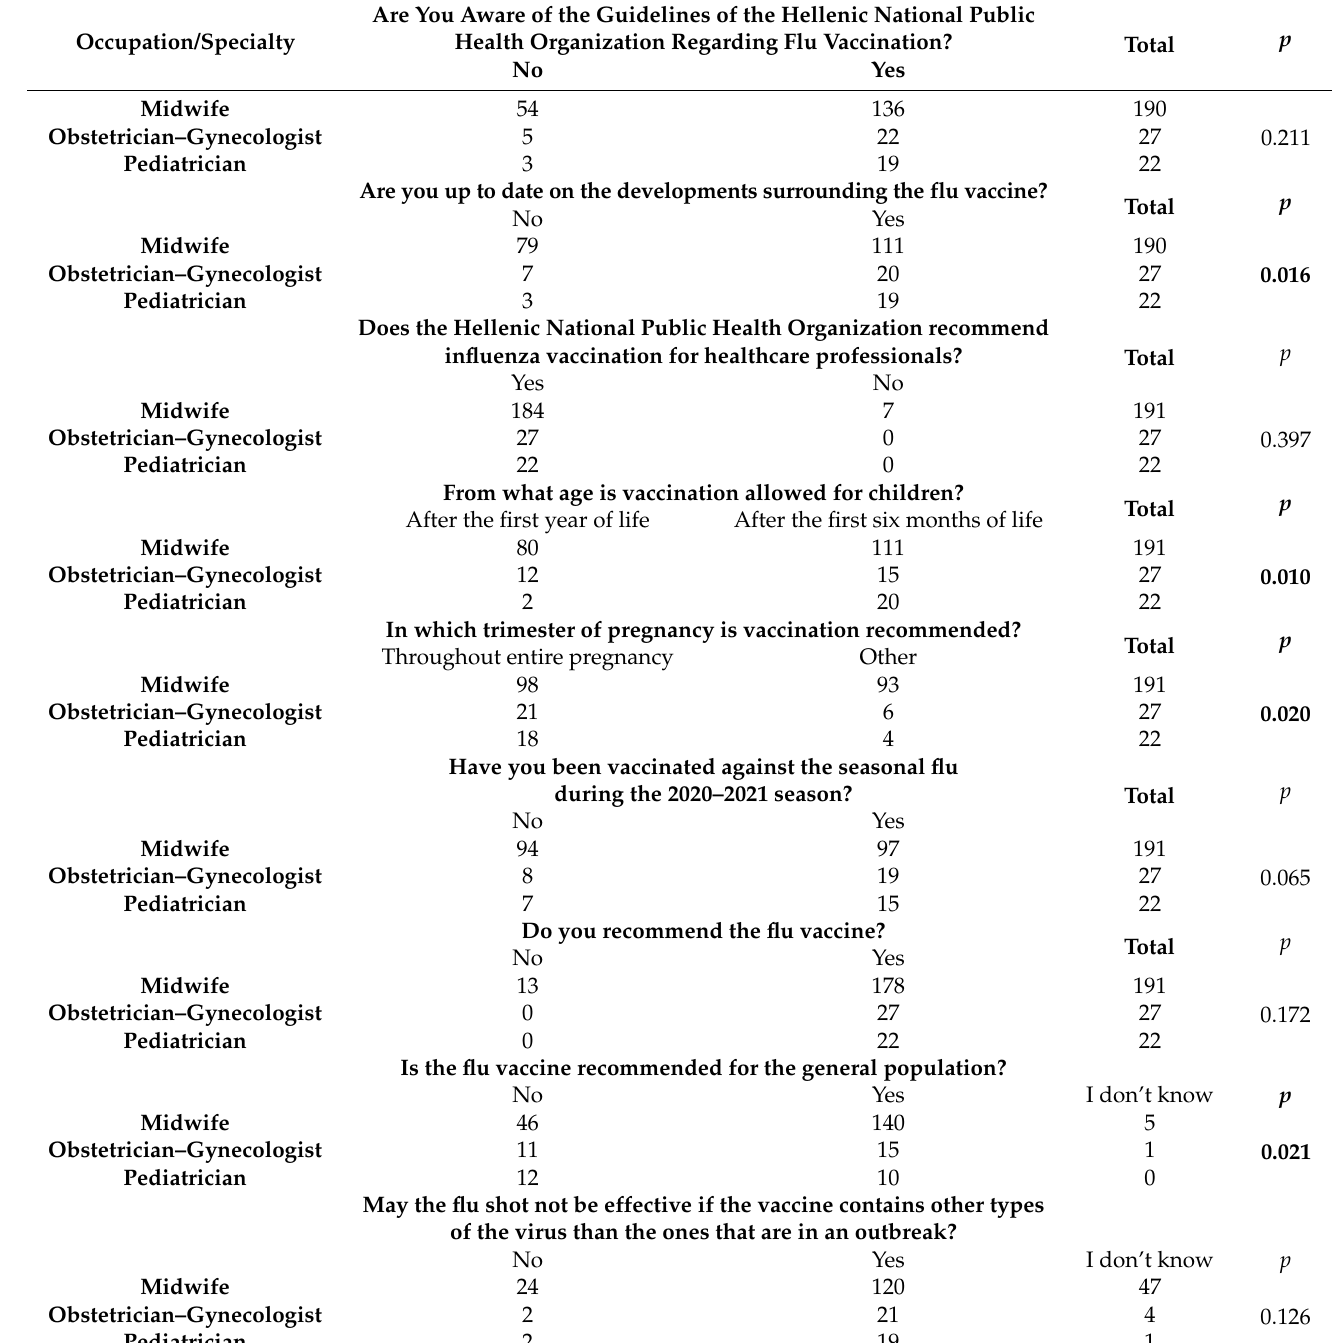
about the flu vaccine. Table 4. Associations between occupation/specialty and knowledge